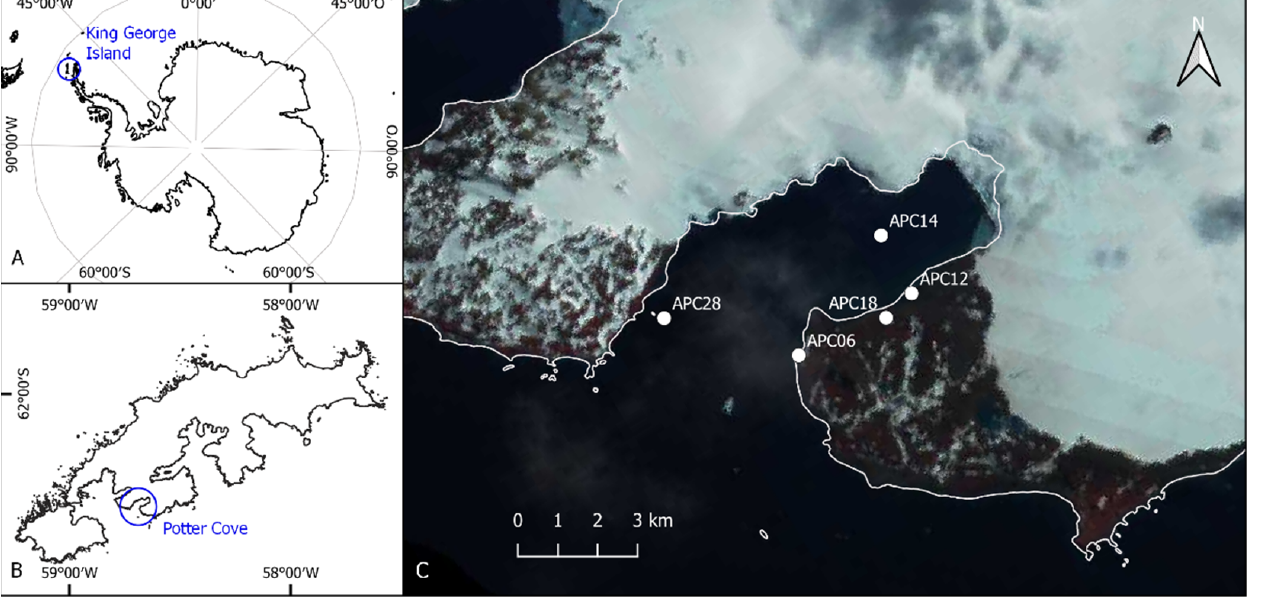
Figure 1. Sampling points: ( A ) map of the Antarctic, ( B ) map of King George Island, and ( C ) sample points in the Potter Cove: limnic location APC18, brackish water location APC12, and marine locations APC06, APC14, and APC28. Basemap: Landsat image mosaic of Antarctica (LIMA). Table 1. List of sample locations at Carlini Station, King George Island, Potter Cove, in austral summer 2020 (January/February), with information on sample site, altitude or water depth, sample date, collector georeferenced, and sampled substrate; a.s.l.: above sea level.